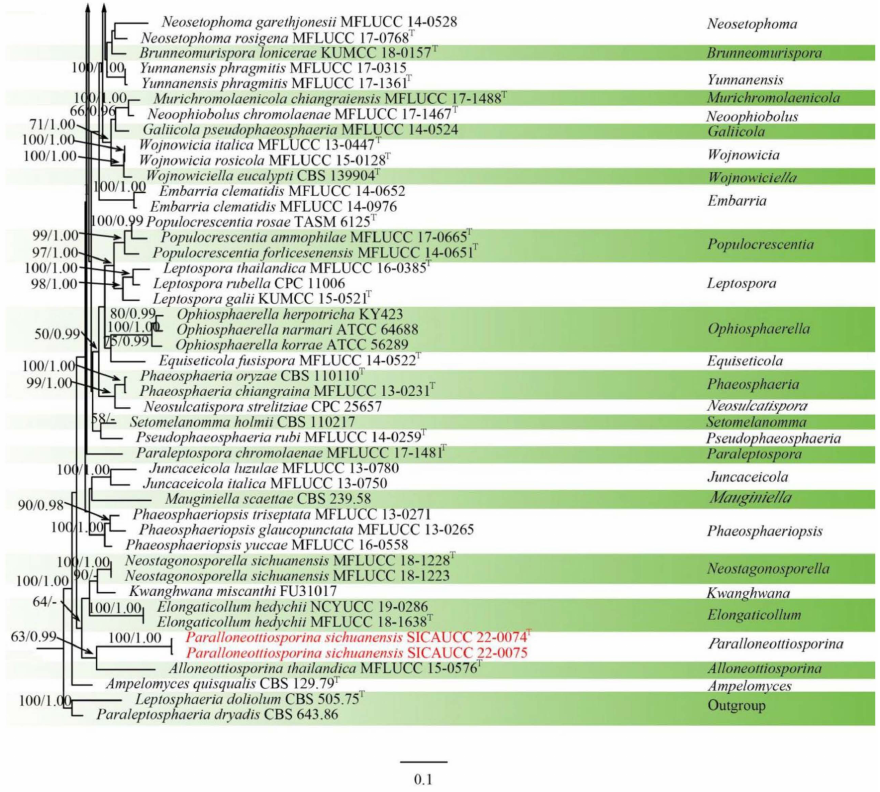
Figure 3. Phylogram generated from RAxML analysis based on combined ITS, LSU, SSU, and tef1- α sequence data of Phaeosphaeriaceae. Bootstrap support values for maximum likelihood (ML, left) higher than 50% and Bayesian posterior probabilities (BYPP, right) equal to or greater than 0.90 are indicated at the nodes, respectively. The sequences from ex-type strains are marked by a superscript symbol T. The newly generated sequences are written in